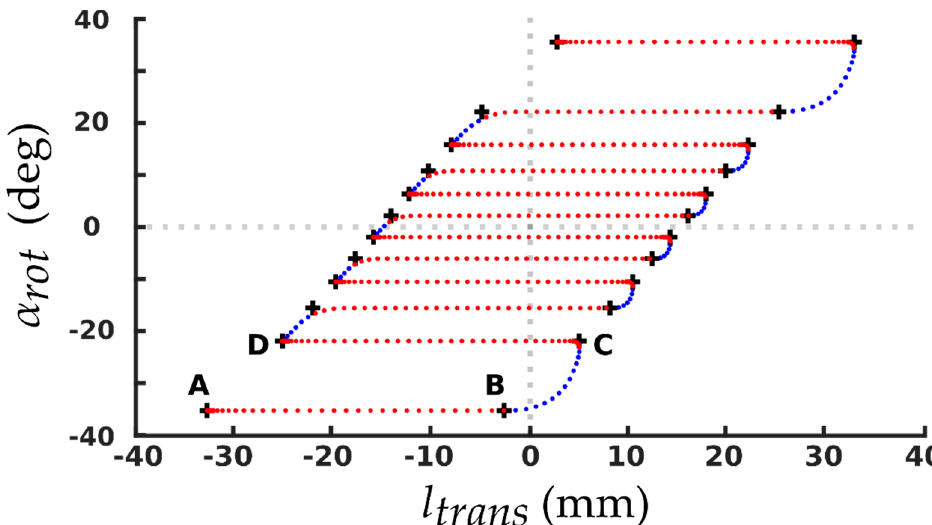
Figure 2. Successive motor positions for a rotate-translate scan with the angular sampling period Δ α 2 ≈ 4 ◦ . Positions used for reconstruction are shown with red markers. Blue markers designate positions that are necessary for the continuous mechanical scan but are discarded prior to volume reconstruction. The black crosses represent targeted endpoints for the motor trajectories. Because of the density taper, the effective angular step is 4 ◦ around α rot = 0 and increases with the value of | α rot | . The bounds of the angular range [ − 45 ◦ , 45 ◦ ] are also not reached. The first four endpoints are notated A, B, C, and D. The corresponding video of the scanner in action is displayed in Video S1.